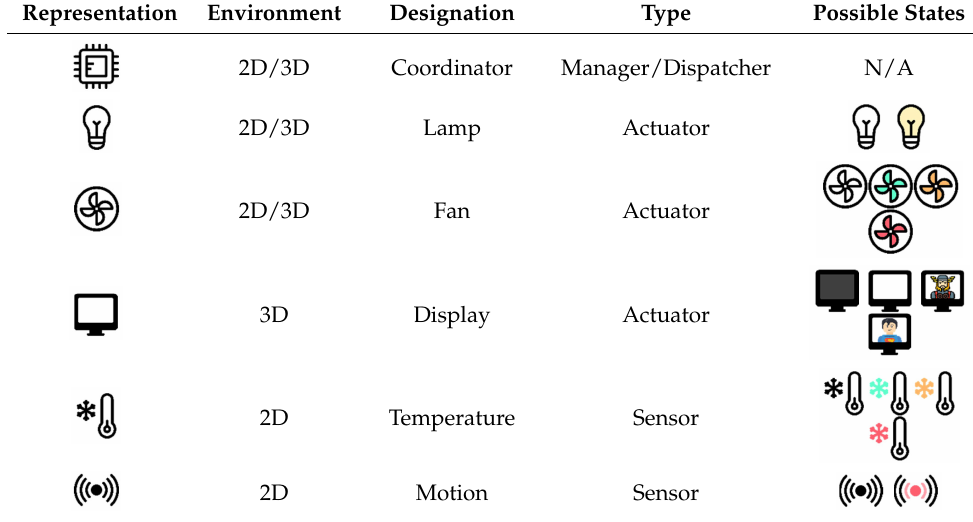
Table 3. Demonstration symbology regarding the 2D and 3D virtual environments established by using the proposed prototyping software.